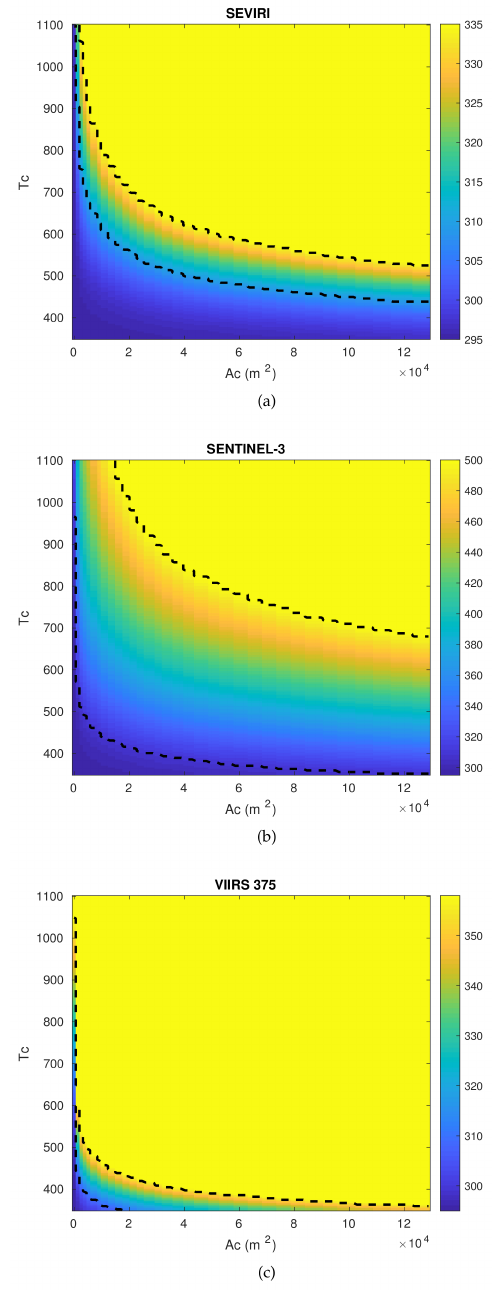
Figure 1. Simulated Response Map for each remote sensor: ( a ) SEVIRI; ( b ) SENTINEL-3 SLSTR; ( c ) VIIRS-375. The maximum area covered by the cooling lava ( A c ) corresponds to the VIIRS-375 pixel area (14 × 10 4 m 2 ) less the hotter constant area set to 100 m 2